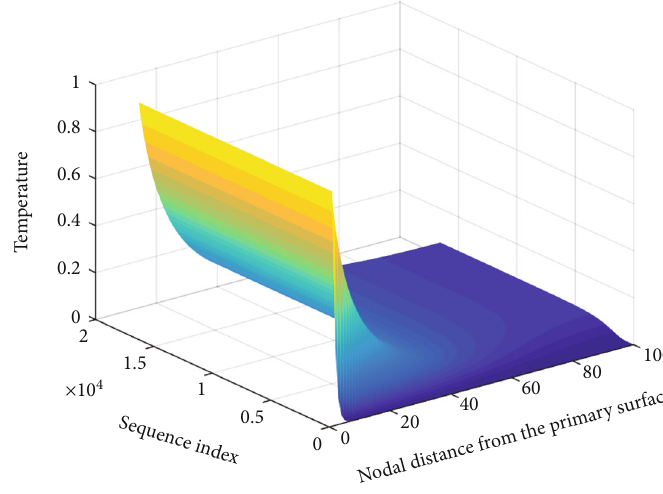
Figure 9: Result surface.